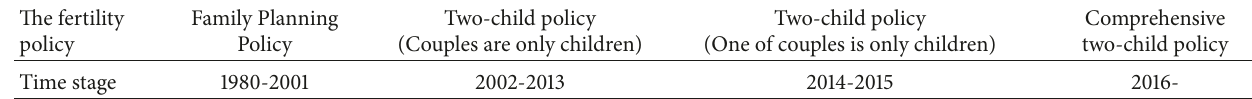
Table 9: The four stages of Chinese fertility policies.